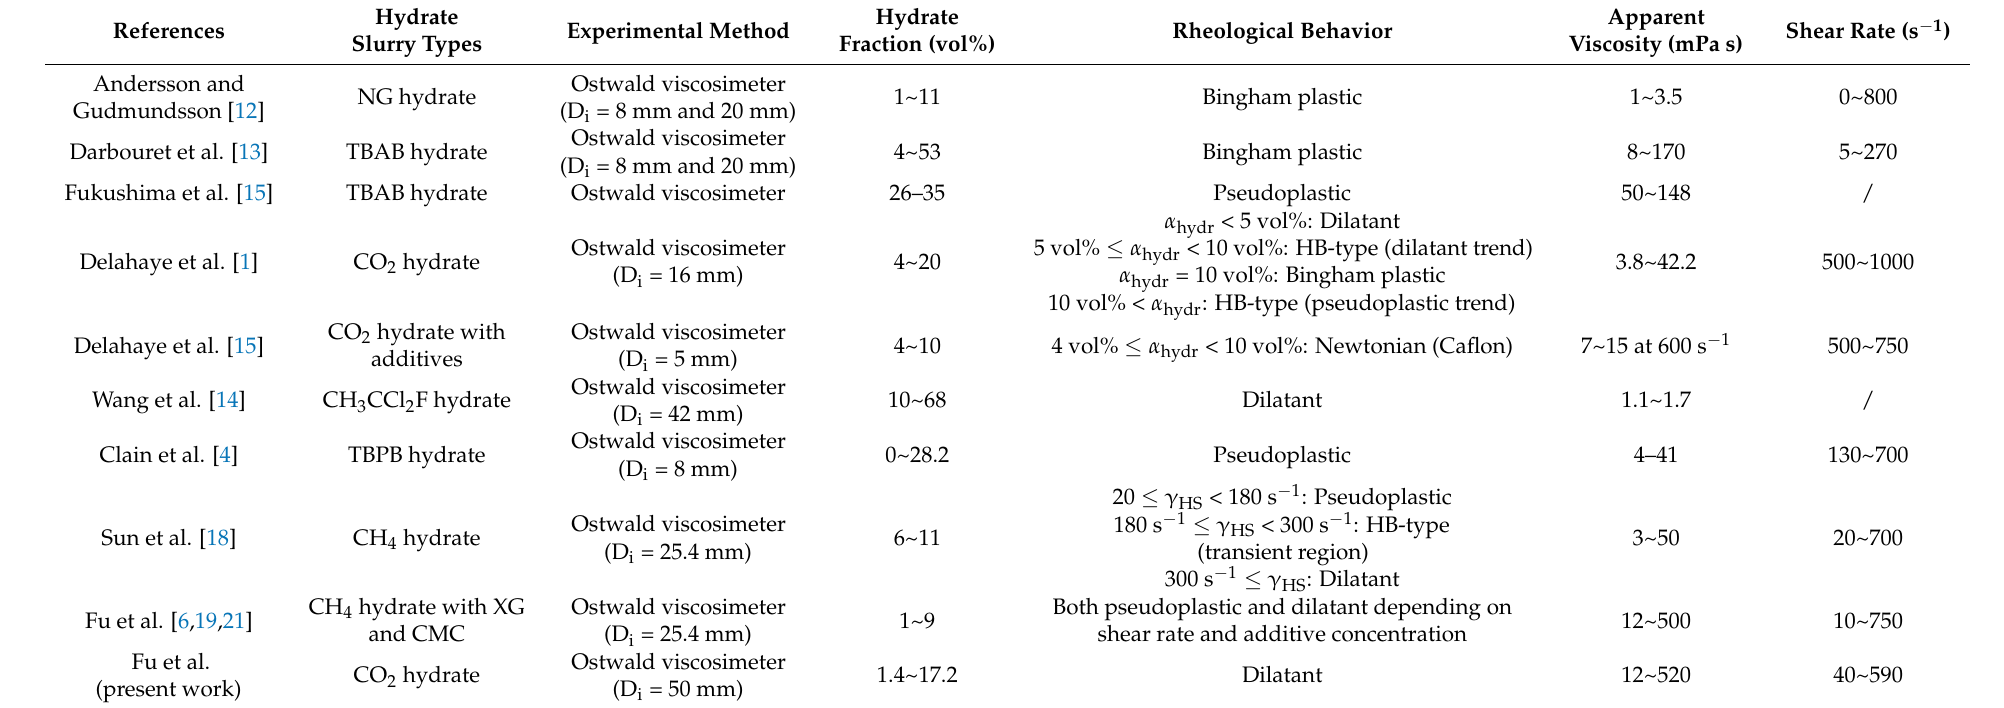
Table 1. Rheology of hydrate slurries in aqueous phase